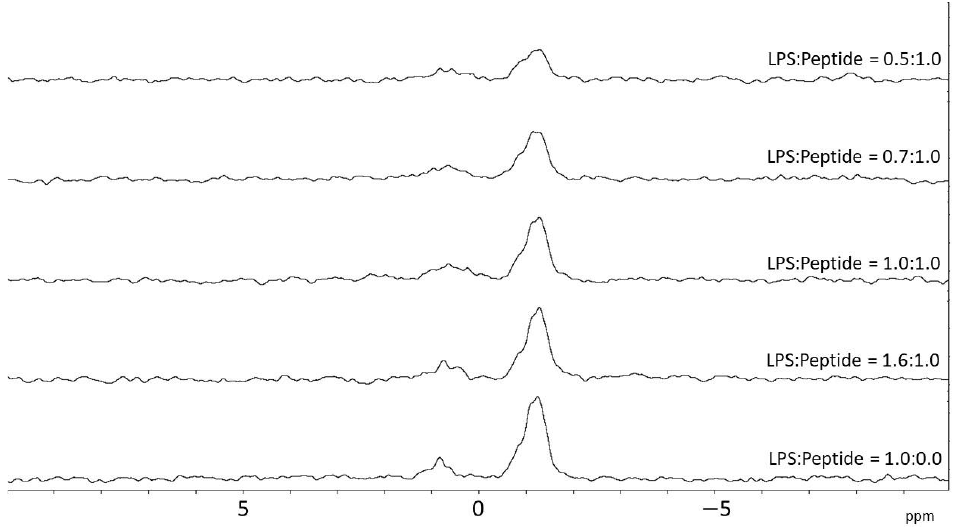
Figure 6. Phosphorous NMR of lipopolysaccharide from E. coli in the presence of increasing amounts of crabrolin21. LPS from E.coli was titrated with increasing amounts of crabrolin21. Measurements were performed at 298 K and pH 6.5.